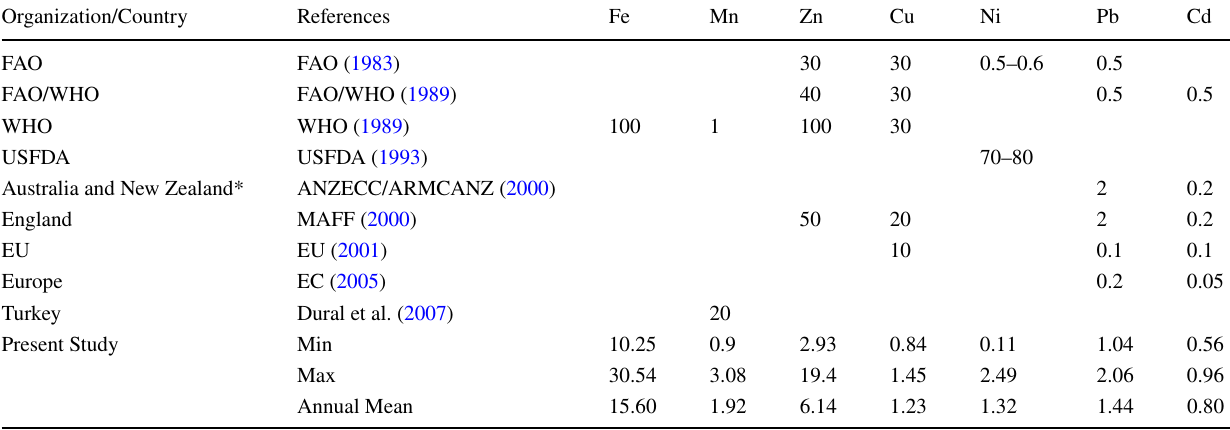
Table 8 Minimum, maximum and annual mean of heavy metals concentrations (µg/g wet weight) in muscles of Oreochromis niloticus collected from Mariout Lake in comparison with the international standard permissible limits